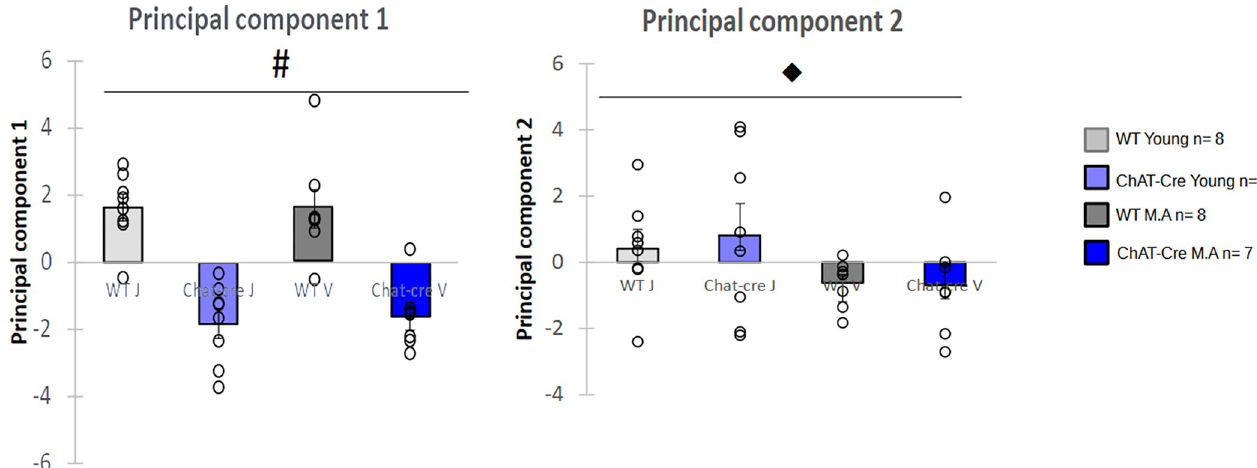
Fig 10. Repartition of each group on the two main components of PCA. A) Repartition of each group on the first main component B) Repartition of each group on the second component. WT young n = 8, ChAT-Cre young n = 8, WT Middle Age (M.A.) n = 8, ChAT-Cre Middle Age n = 7. Data are presented as means ± SE; � p < 0.05; �� p < 0.01; ��� p < 0.001; Kruskal-Wallis rank-sum test analysis then Wilcoxon and d signed-rank tests were applied when appropriate. # represents the genotype effect and ◆ the age effect. Kruskal-Wallis results were not represented for